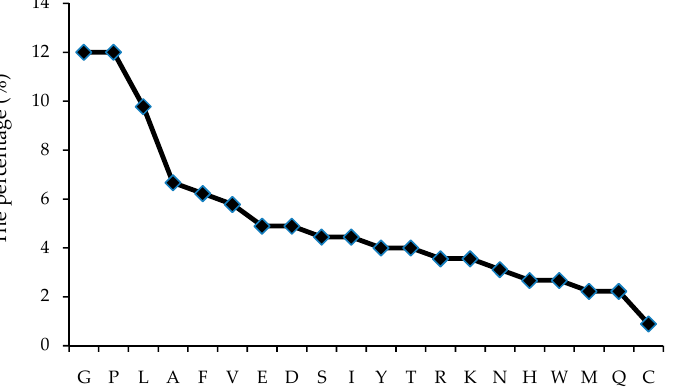
Figure 3. The percentage of each amino acid in the total AAs from 42 antioxidant peptides.